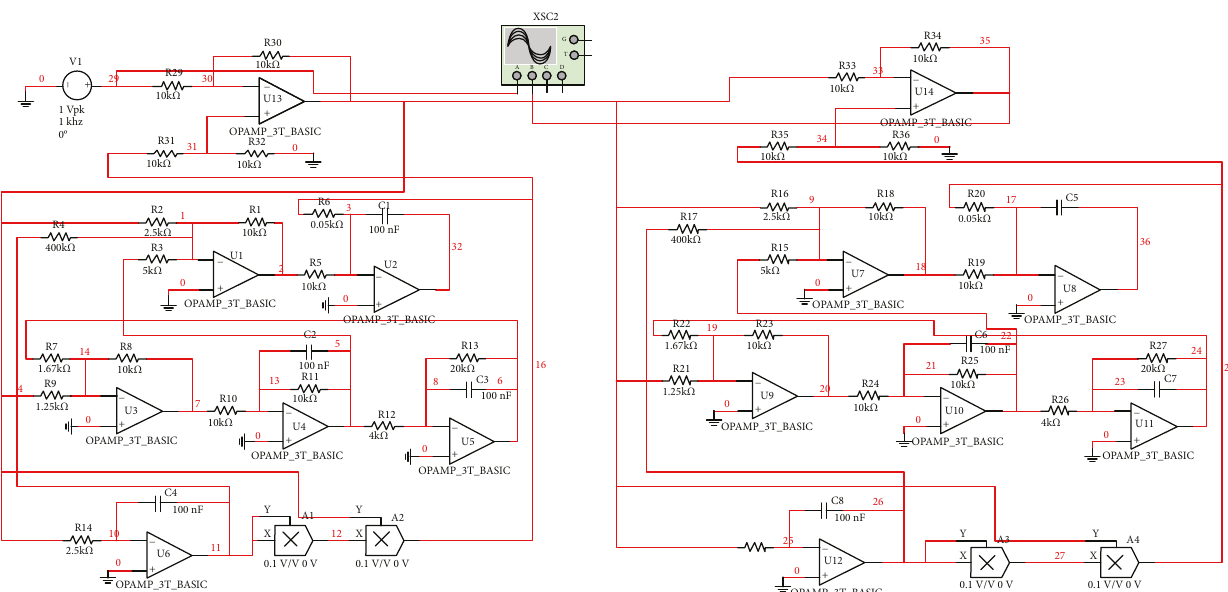
Figure 14: A novel memductor-based secure communication circuit by